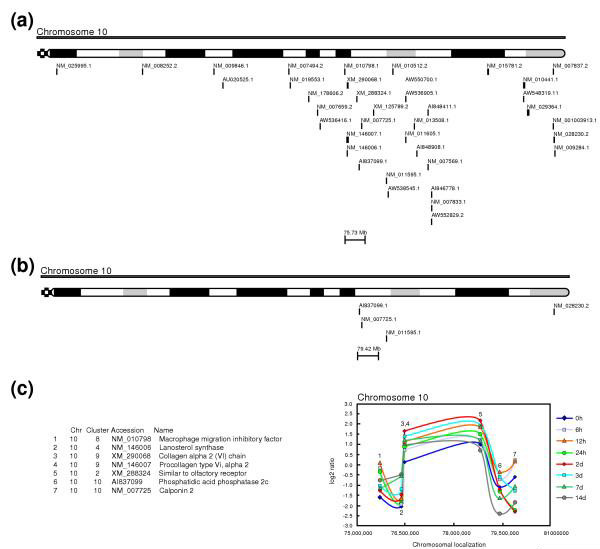
Chromosomal localization analysis for ESTs found to be differentially expressed during fat cell differentiation. Chromosomal localization analysis for chromosome 10 from 780 ESTs shown to be more than two times upregulated or downregulated in a minimum of four time points during adipocyte differentiation. (a) Mapped ESTs to chromosome 10. (b) ESTs from cluster 10 mapped to chromosome 10. (c) Relative gene expression levels (log2 ratios) at different time points for seven ESTs mapped within a genomic interval of 5 Mb from chromosome 10. EST, expressed sequence tag.